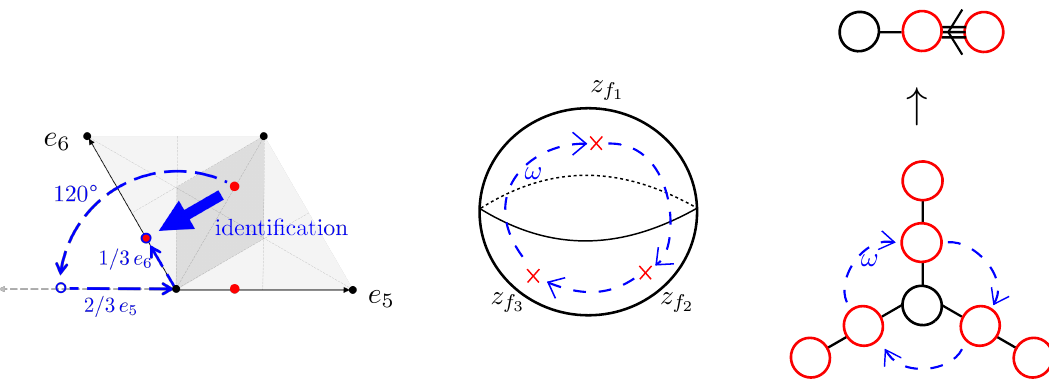
Figure 7 . A depiction of the three Z 3 fixed points of ϑ and their identification by the element ω . In the left we show the reduction of the fundamental domain and its action on the singular P 1 . On the right we depict the action on the resolved fibers twisting the E (1)